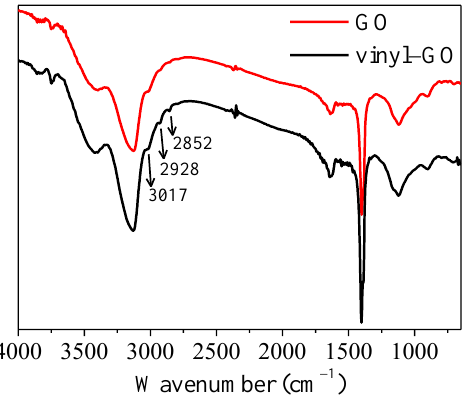
Figure 1. FTIR spectra of GO and vinyl − GO.